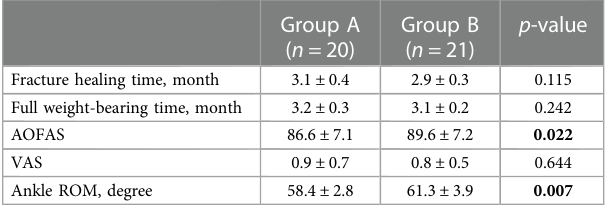
TABLE 3 Clinical and radiographic outcomes of the two